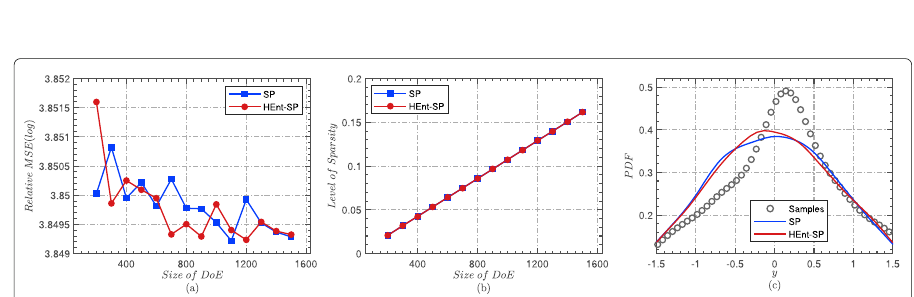
Fig. 12 Performance comparison of SP, Ent-SP and HEnt-SP w.r.t. the high-dimensional function. ( a ) The relationship between the relative MSE and the size of DoE; ( b ) The relationship between the sparsity level of several methods and the size of DoE; ( c ) Enlarged details of the reconstructed PDF